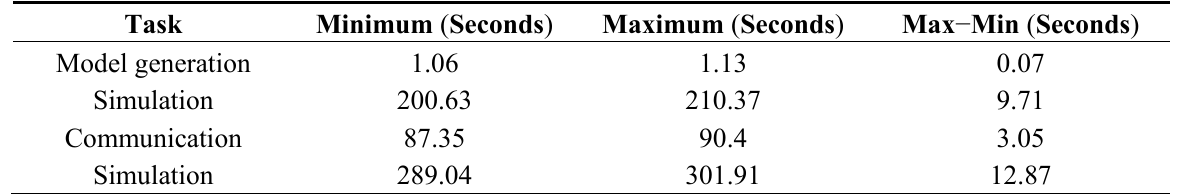
Table 2. System performance for modeling, simulation and simulation cycle.